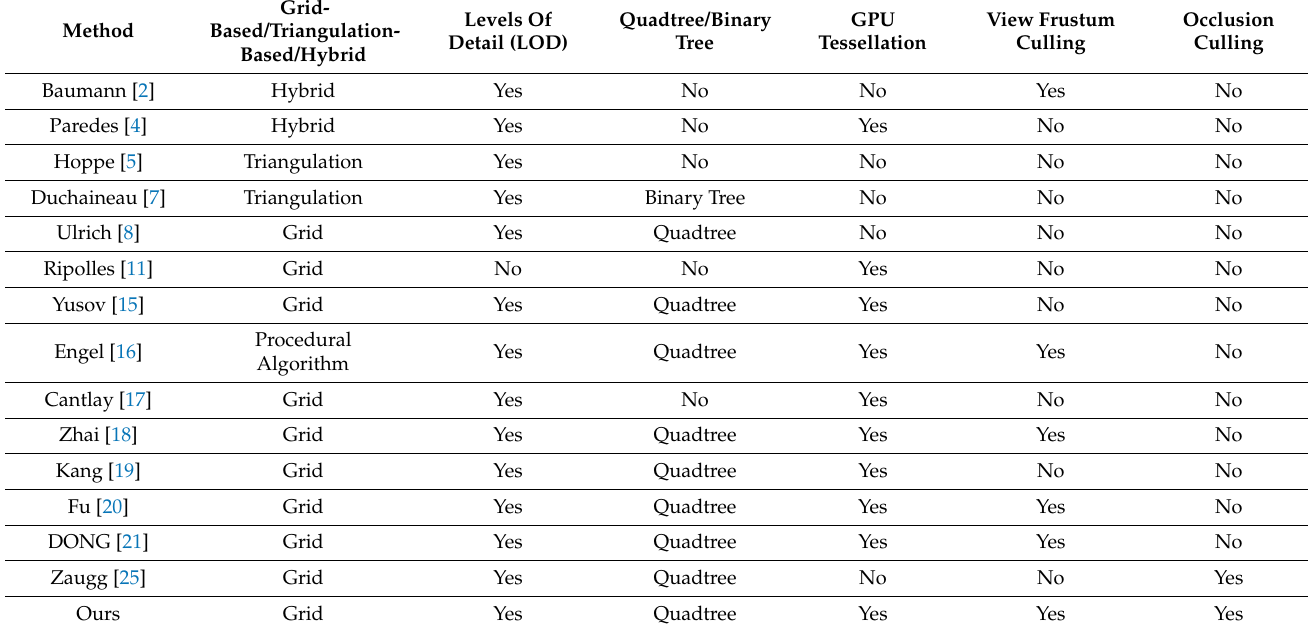
Table 1. Comparison of the various